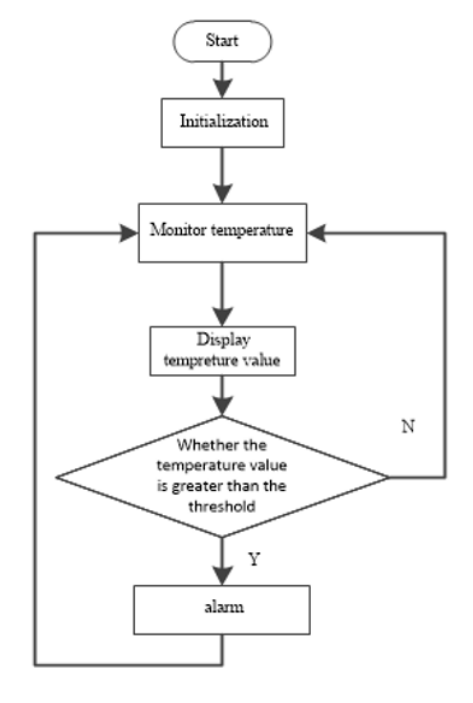
Fig. 6. The flowchart of the temperature collection